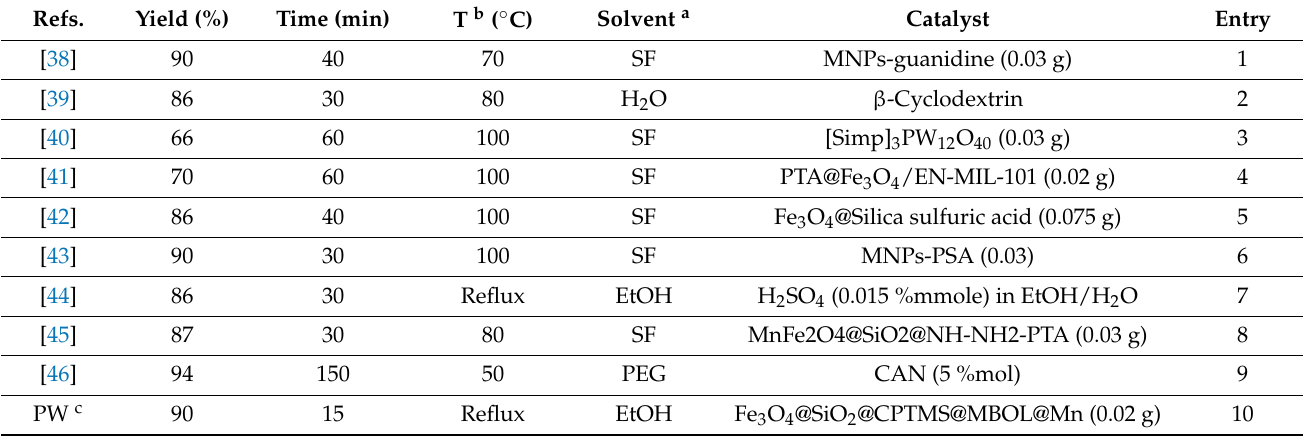
Table 3. Comparison of the Mn-supported nano-catalyst capability with the other catalysts in synthesis of 3,4-dihydro-3,3- mimethyl-13-(4-methylphenyl)-2 H -indazolo[2,1- b ]phthalazine-1,6,11(13 H )-trione.